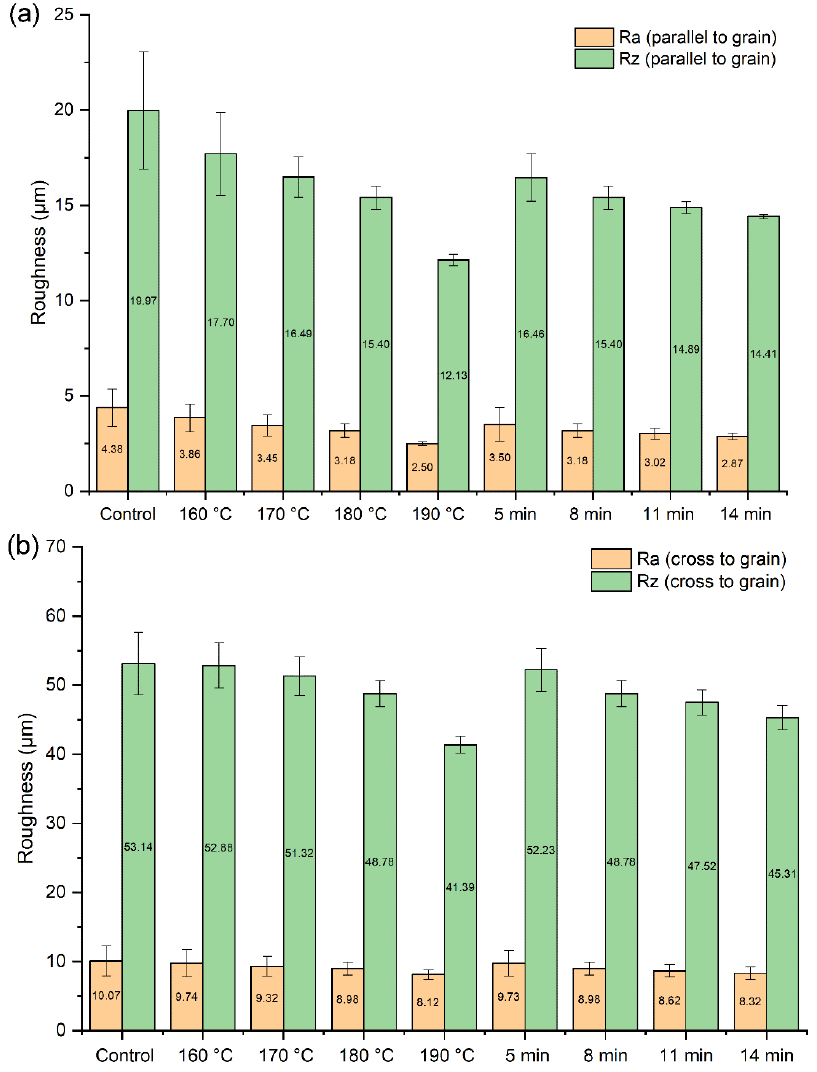
Figure 2. Effect of TPM temperature and duration on the roughness parallel to grain ( a ) and the roughness on the cross grain ( b ) of the thick veneer surfaces.